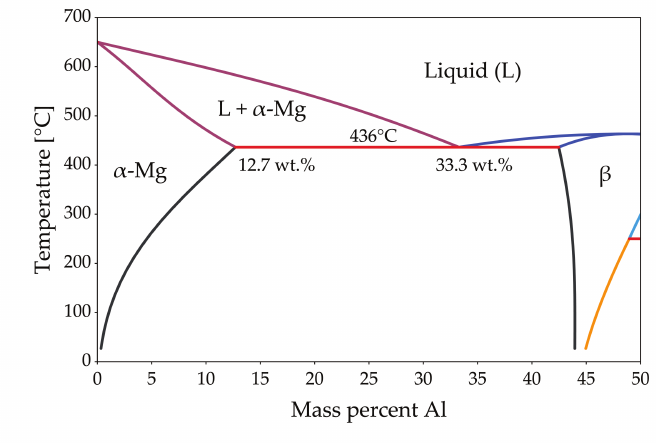
Figure 6. Phase diagram of the Mg-Al binary system. For further information, see Appendix A.